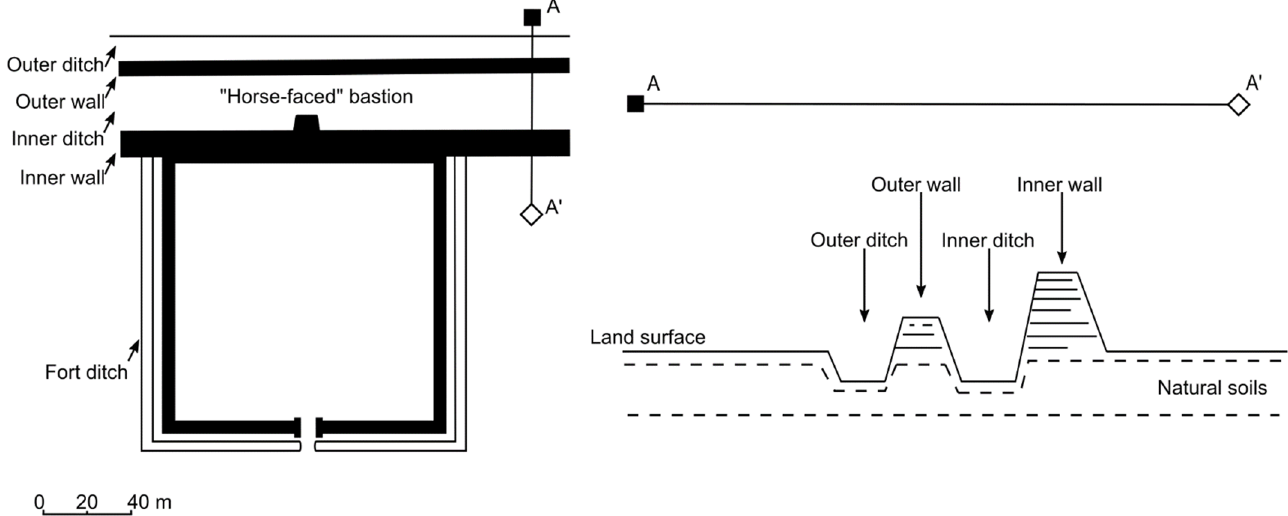
Figure 11. Typical construction method found along the main line of the MWS (figure adapted from ([50], pp. 293–294)).